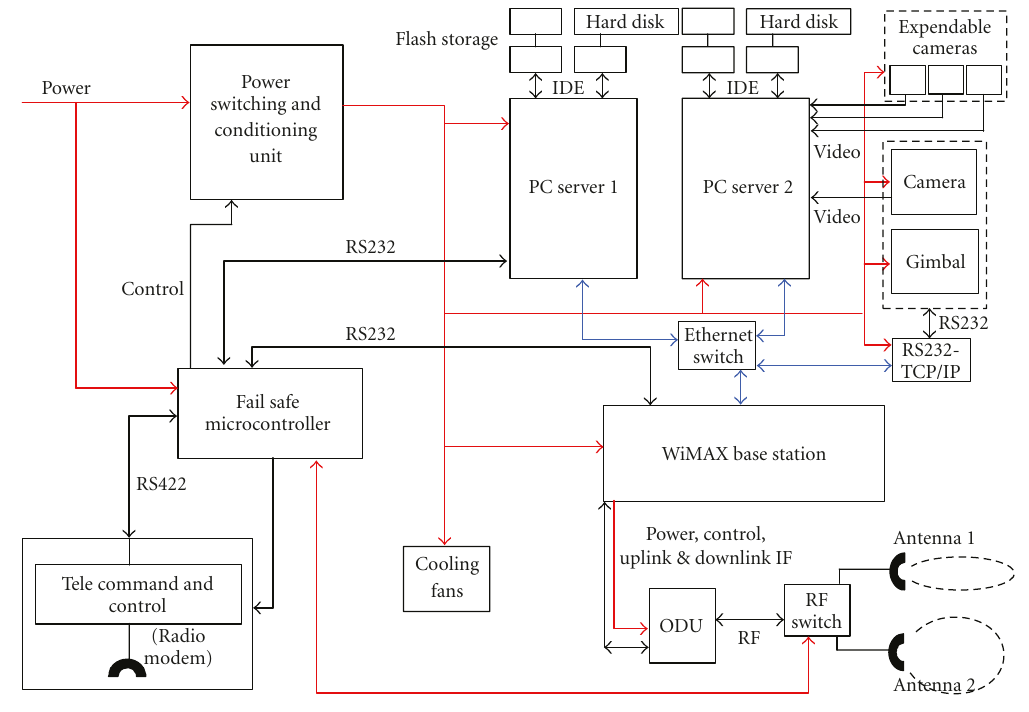
Figure 2: High-level payload system